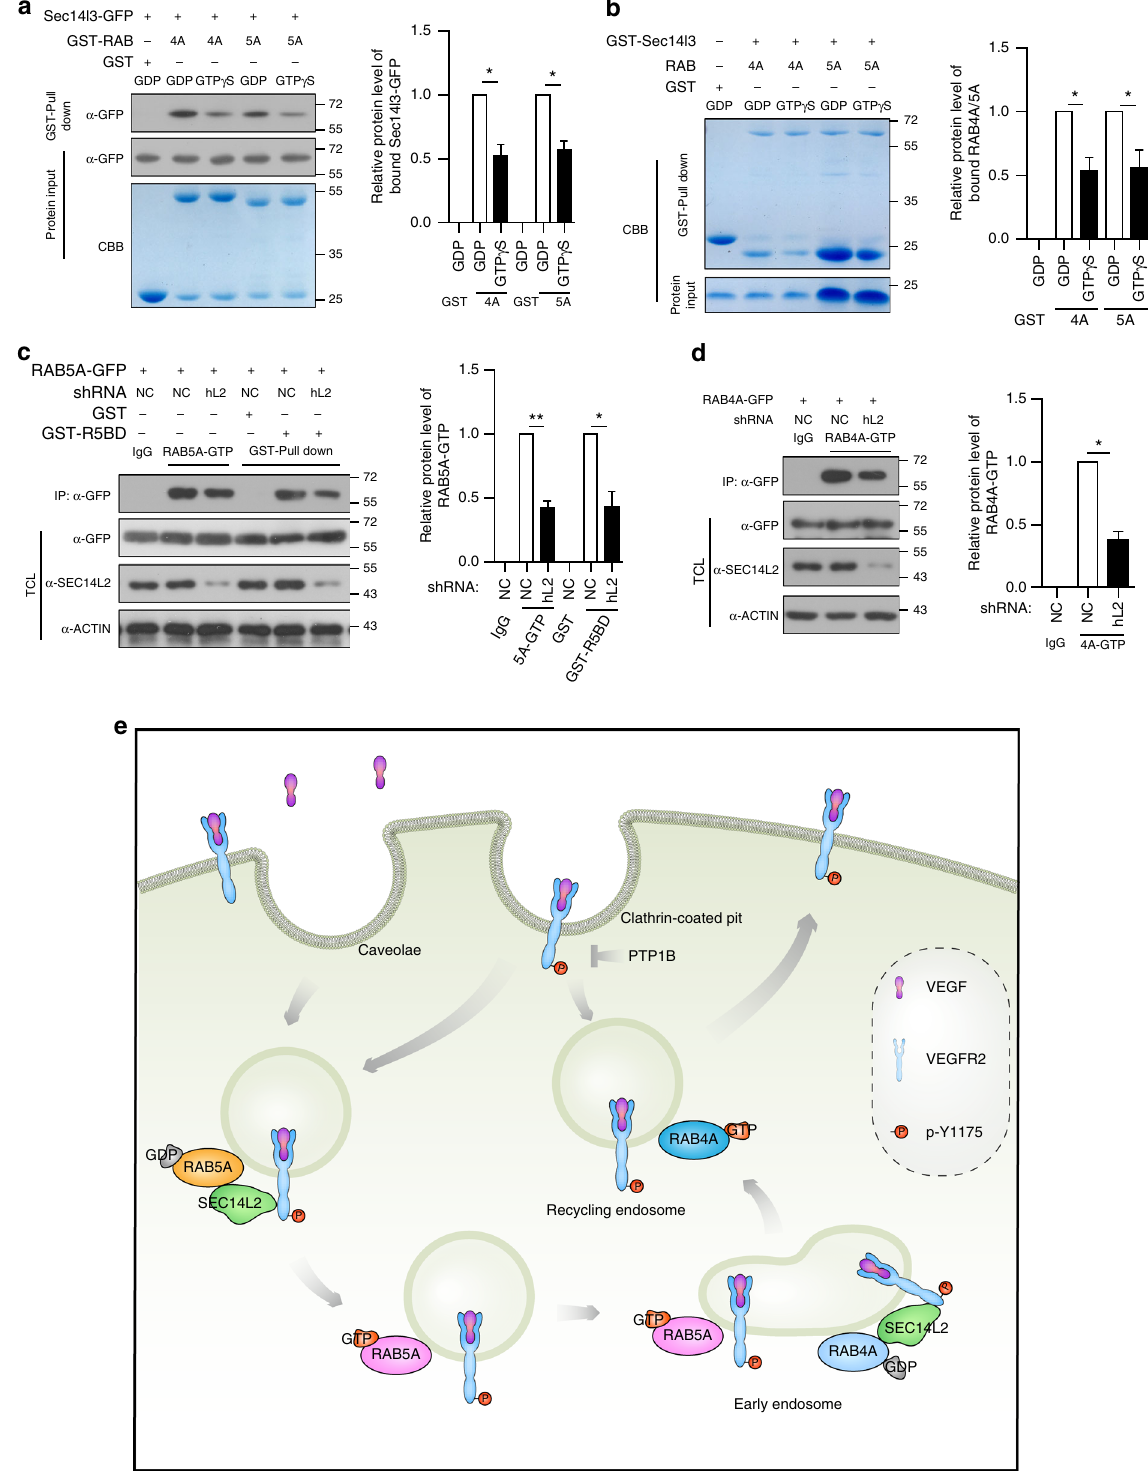
Methods Zebra fi sh strains and embryos manipulation . Tuebingen strain of zebra fi sh ( Danio rerio ) was used. Unless otherwise stated, Tg(kdrl:GFP) s843Tg and Tg( fl i1a: EGFP) y1 transgenic lines were used for easy observation of vasculature develop- ment. Ethical approval is acquired from Tsinghua University Animal Care and Use Committee for the fi sh maintenance and manipulations, according to the institutional animal care and use committee (IACUC) protocol (AP#13-MAM1). Embryos were raised and staged according to Kimmel et al. 69 . For injection, 1-cell stage embryos were harvested and injected with mRNAs or MOs in yolk for even NATURE COMMUNICATIONS| (2019) 10:1606